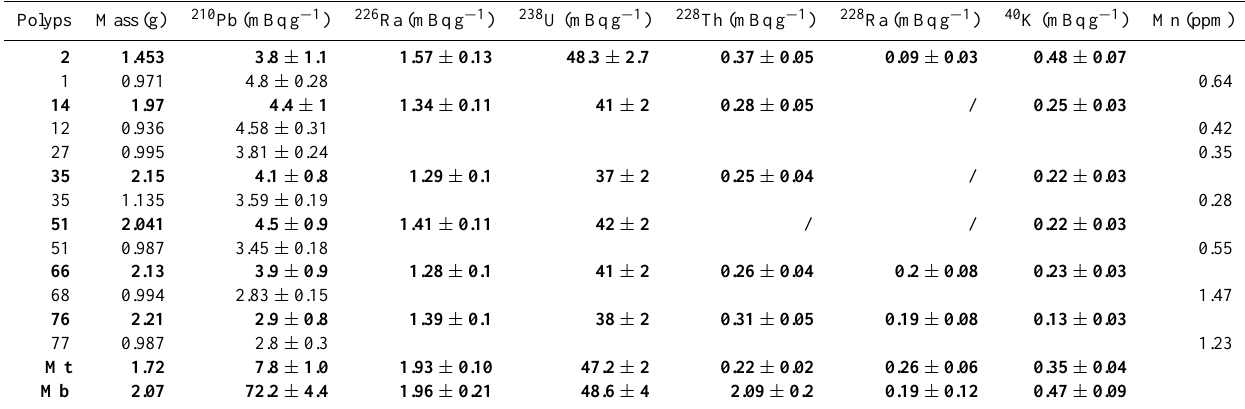
Table 1. Radiometric data from the Madrepora oculata specimen, activity was determined as milli-Becquerel per gram (mBqg − 1 ) with standard deviation at 1 σ . In bold, data obtained by gamma spectrometry with activities of 210 Pb, 226 Ra, 238 U, 228 Th, 228 Ra and 40 K. In regular, 210 Pb activities obtained by alpha spectrometry. Mn contents were expressed in ppm.